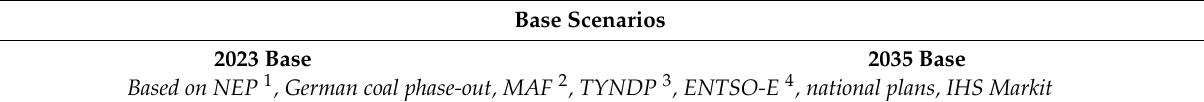
Table 1. Overview scenarios and